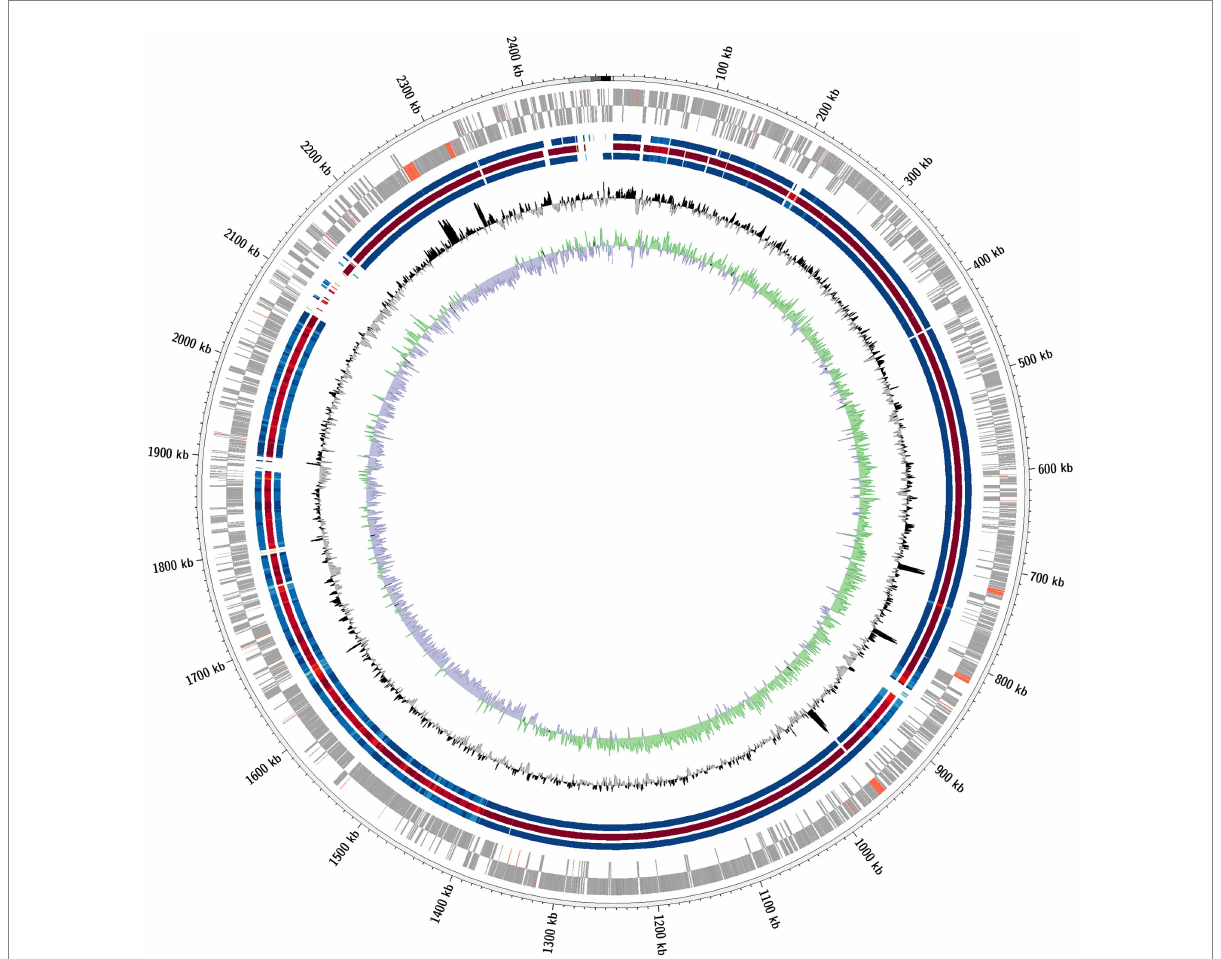
FIGURE 2 Comparative circular genome plot. Depicted is a comparative circular genome plot of the strains D3, K1 and H17 against the type strain D2 T . From outward to inward: coding genes (grey) and non-coding genes (red) of the forward and reverse strand, respectively; Homolog genomic regions of strains D3 (blue), K1 (red) and H17 (blue), respectively; GC content and GC